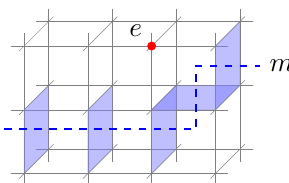
Figure 9. An e -particle and an m -string in the 3d toric code